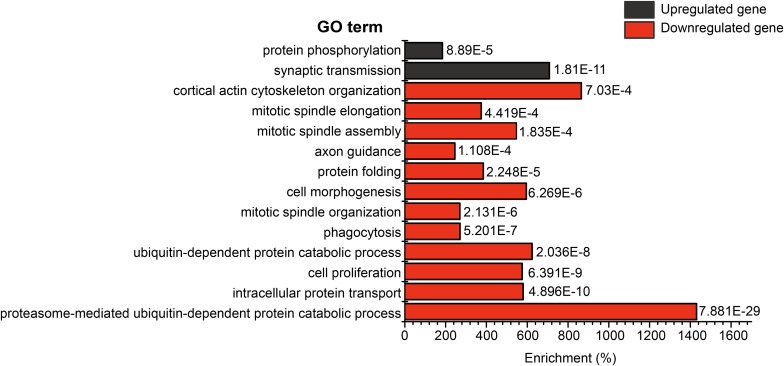
SAGA deubiquitinase-regulated genes are enriched for Gene Ontology terms including proteasome function, protein folding, and axon targeting. Significantly enriched biological process GO terms (FDR < 0.001) of upregulated genes (black) and downregulated genes (red) in both nonstop and sgf11 optic lobe glia. Adjusted p-values for each GO term are shown to the right of each bar. Enrichment (x-axis) represents the fold increase of the number of genes in each GO term over the number expected by chance. FDR, false discovery rate; GO, Gene Ontology; SAGA, Spt-Ada-Gcn5 acetyltransferase.